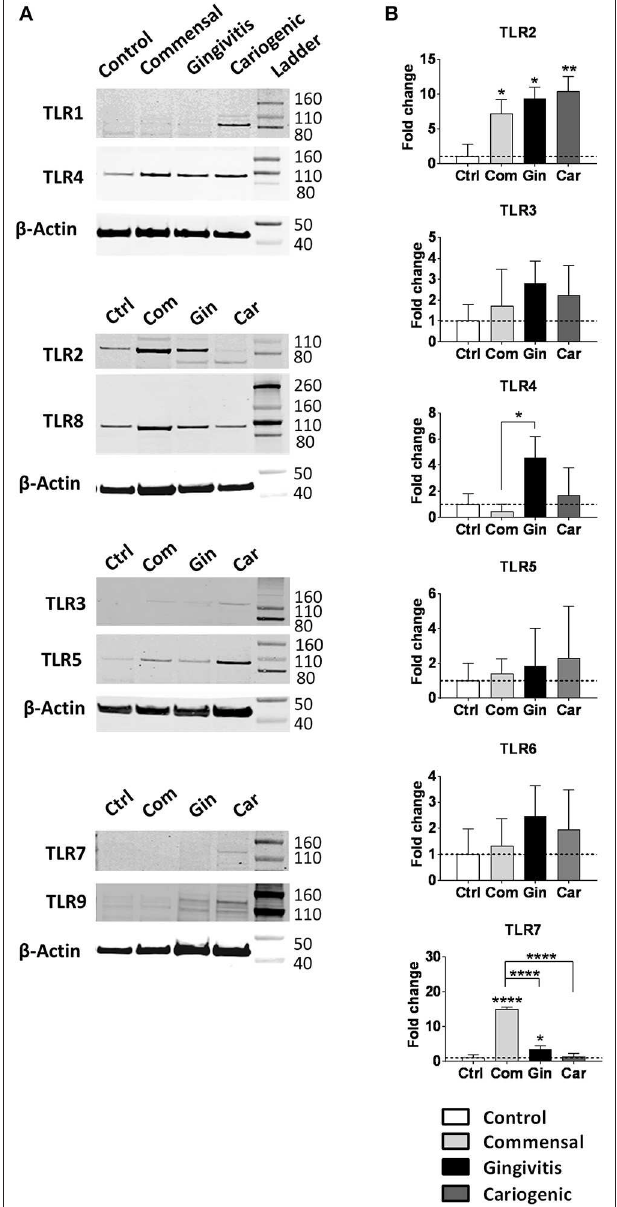
FIGURE 4 | Commensal, gingivitis, and cariogenic biofilms regulate TLR expression differently. (A) Western blot analysis of TLRs 1-5 and 7-9 indicate the presence or absence of TLR proteins in RHG epithelium after 24h biofilm exposure. (B) The TLR 2-7 mRNA expression after biofilm exposure. Data represent the average of three independent experiments (each with an intra-experiment duplicate) ± SD; * p < 0.05; ** p < 0.01; **** p < 0.0001; one-way ANOVA followed by Bonferroni’s multiple comparison for comparison between groups.